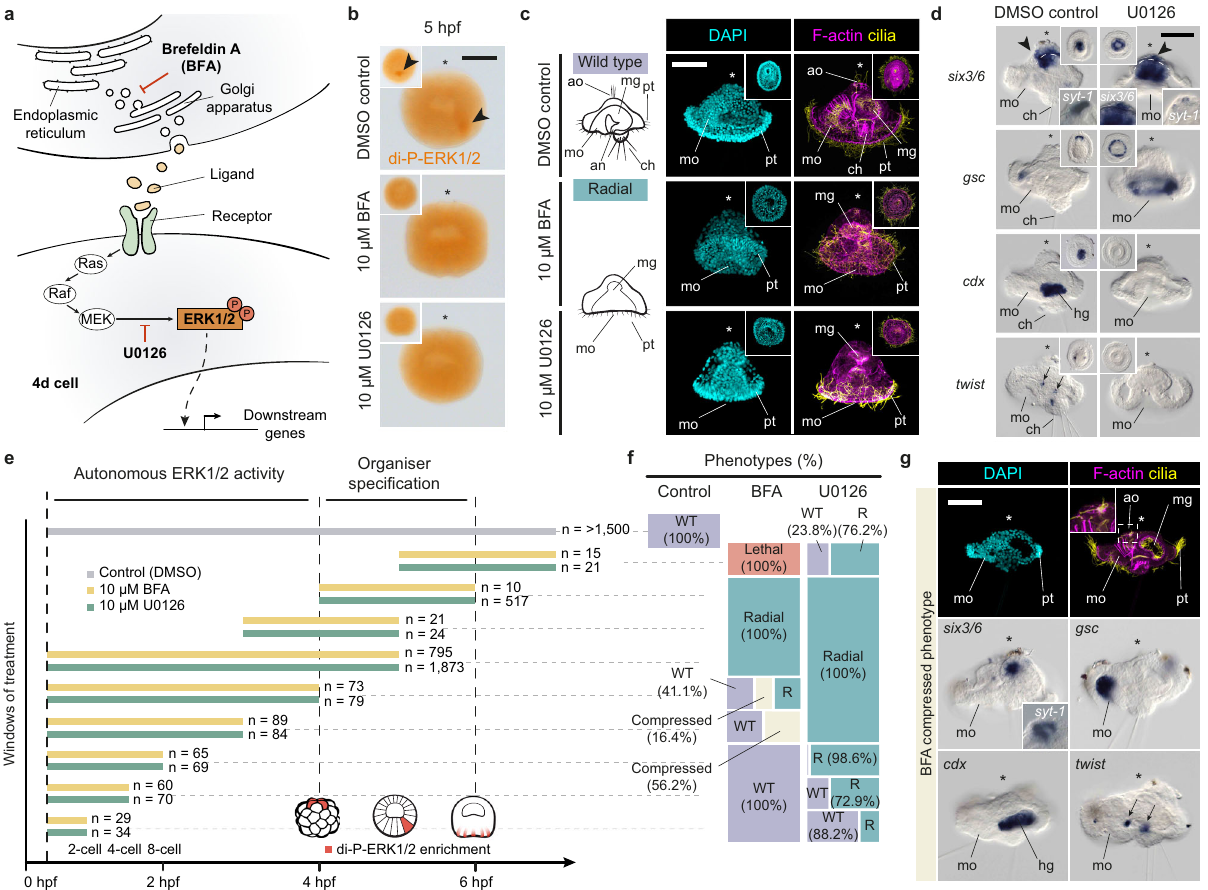
Fig. 3 ERK1/2 signalling controls axial polarity in O. fusiformis . a Schematic drawing of the ERK1/2 signalling cascade and mode of action of Brefeldin A (BFA) and U0126. b Whole mount immunostaining against di-P-ERK1/2 (main panels are lateral views; insets are vegetal views). BFA and U0126 treatments from 0.5 h post fertilisation (hpf) to 5 hpf prevent di-P-ERK1/2 enrichment in the 4d cell. c Lateral z-stack projections of control and BFA/ U0126 24 hpf larvae treated from 0.5 – 5 hpf. Insets in treated embryos are ventral views. Cilia are labelled with anti-acetylated tubulin and F-actin with phalloidin. d Whole mount in situ hybridisation on control and U0126 treated (0.5 – 5 hpf) larvae. e Schematic representation of the analysed drug treatment windows. Number of cases is shown to the right of each bar specifying the time interval. f Distribution and percentages of the larval phenotypes observed for each window and experimental condition (WT, wild type; R, radial). g Phenotypic characterisation of the compressed larval phenotype obtained after BFA treatment from 0.5 hpf until 3 – 4 hpf. First row, lateral z-stack projections of larvae stained with DAPI (nuclei), phalloidin (F-actin) and Acetylated Tubulin (cilia). Bottom rows, lateral views of whole mount in situ hybridisation against apical ectodermal ( six3/6 ), oral ectodermal ( gsc ), hindgut ( cdx )